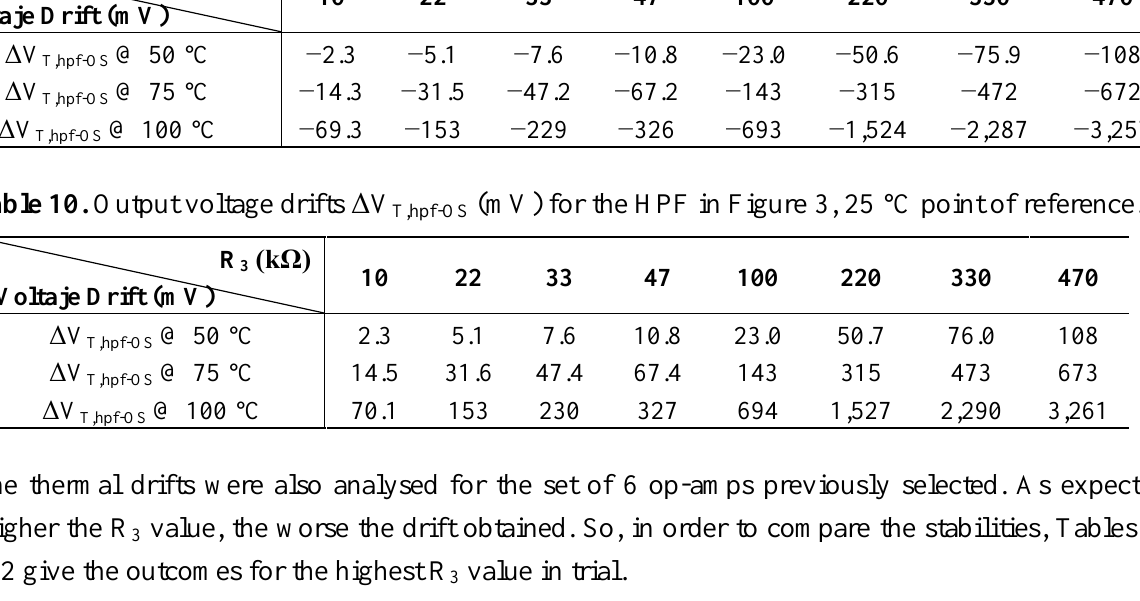
(mV) for the HPF in Figure 4, R T,hpf-OS